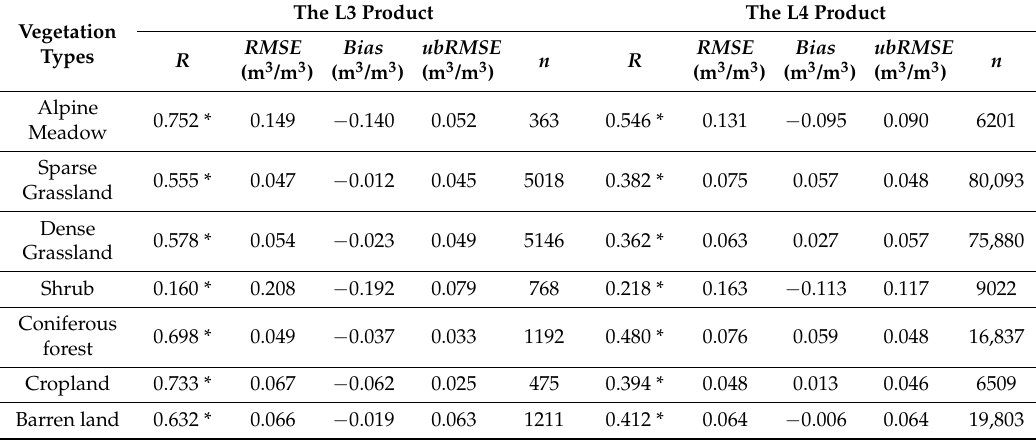
Table 3. Evaluation of the SMAP L3 and L4 products under different vegetation